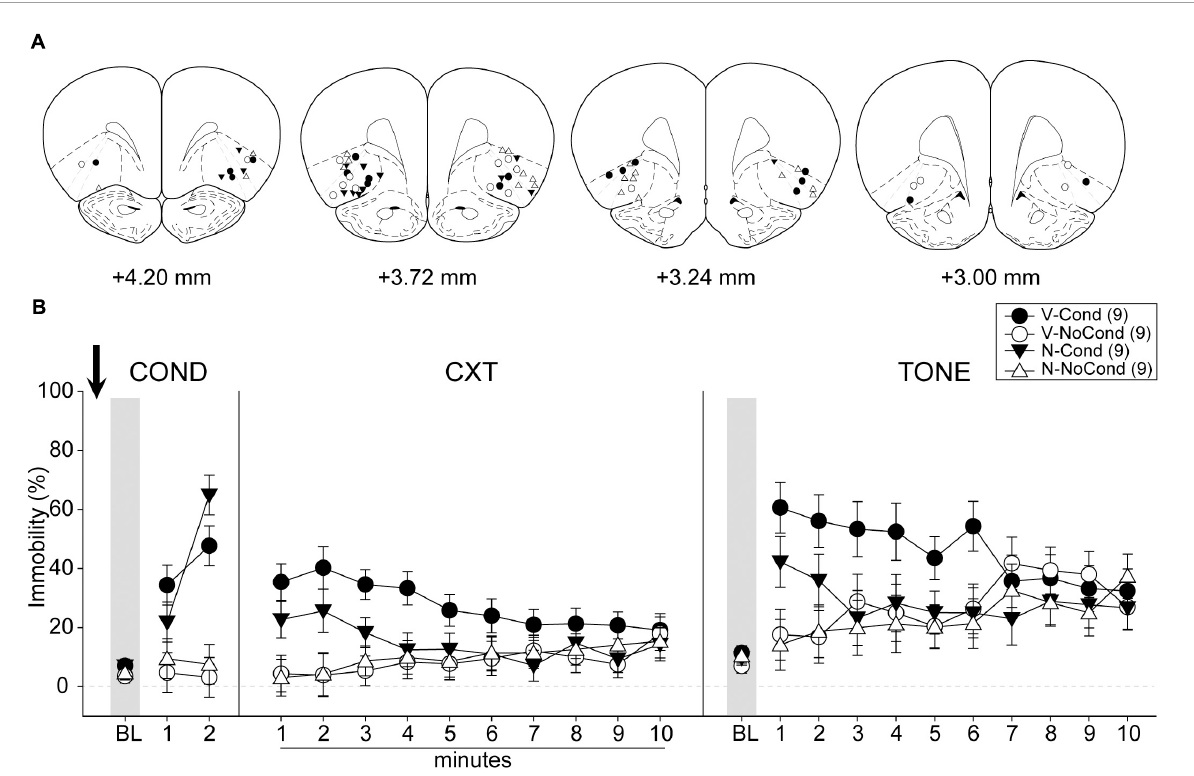
FIGURE3 Lateral OFC (lOFC) activation during fear conditioning interfered with the acquisition/consolidation of cued fear. (A) Injection sites in the lOFC for all the animals included in data analyses at levels of +4.20, +3.72,+3.24, and +3.00 mm, anterior relative to bregma. (B) Percentage of immobility during the conditioning (left panel), contextual test (middle panel), and tone test (right panel). N, N-methyl-D-aspartate (NMDA); V, vehicle; Cond, conditioning; NoCond, no-conditioning. All data are shown as the mean ±